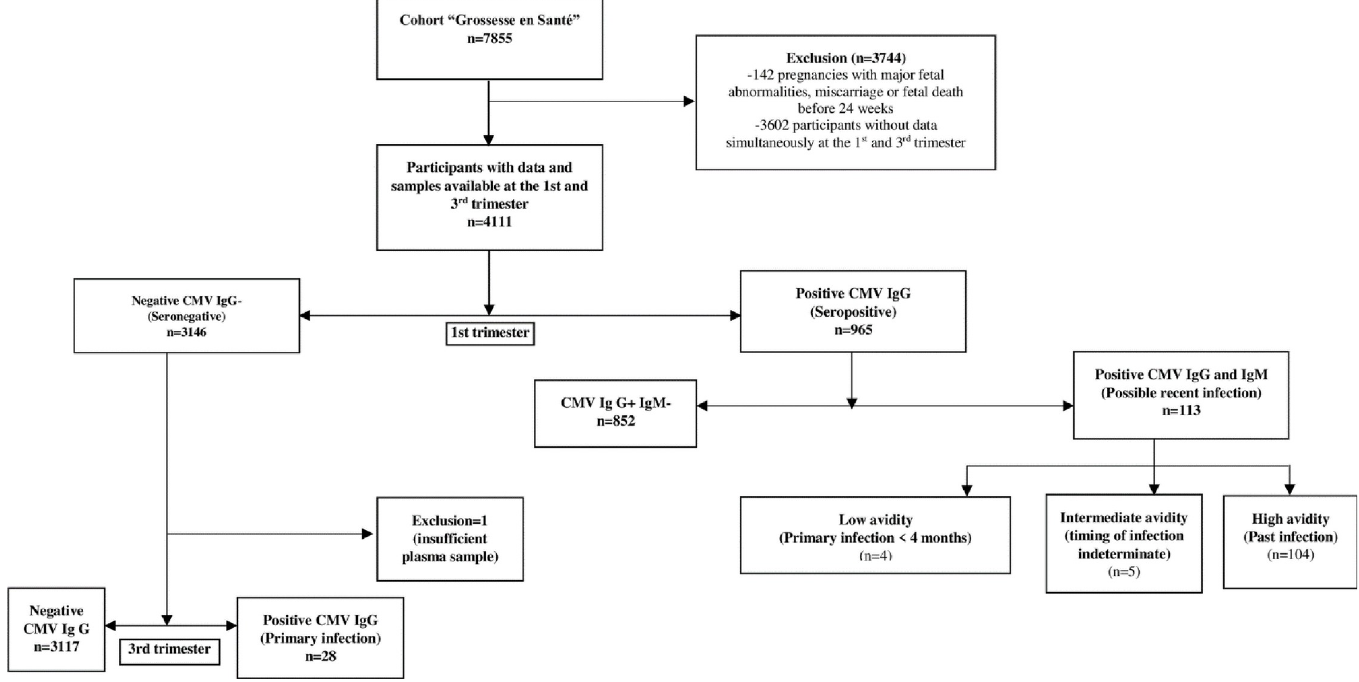
Fig 1. Flowchart of study to detect cytomegalovirus seroprevalence and primary infection among pregnant women of the cohort "Grossesse en sante´".